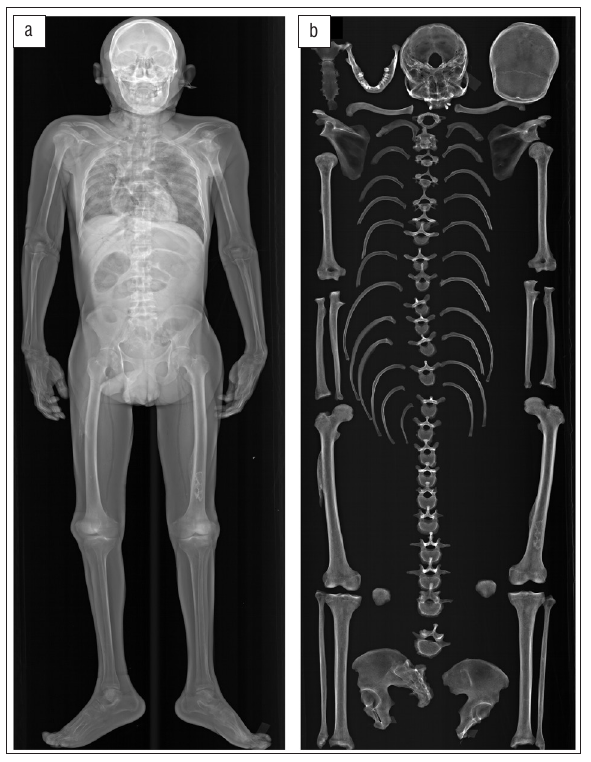
Figure 1: Cadaver K96/13 received in 2013: (a) Lodox ® scan of cadaver prior to dissection by medical students and (b) Lodox ® scan of skeleton in anatomical order (anthropology number An1352). The state of the skeletal remains in the Kirsten Skeletal Collection